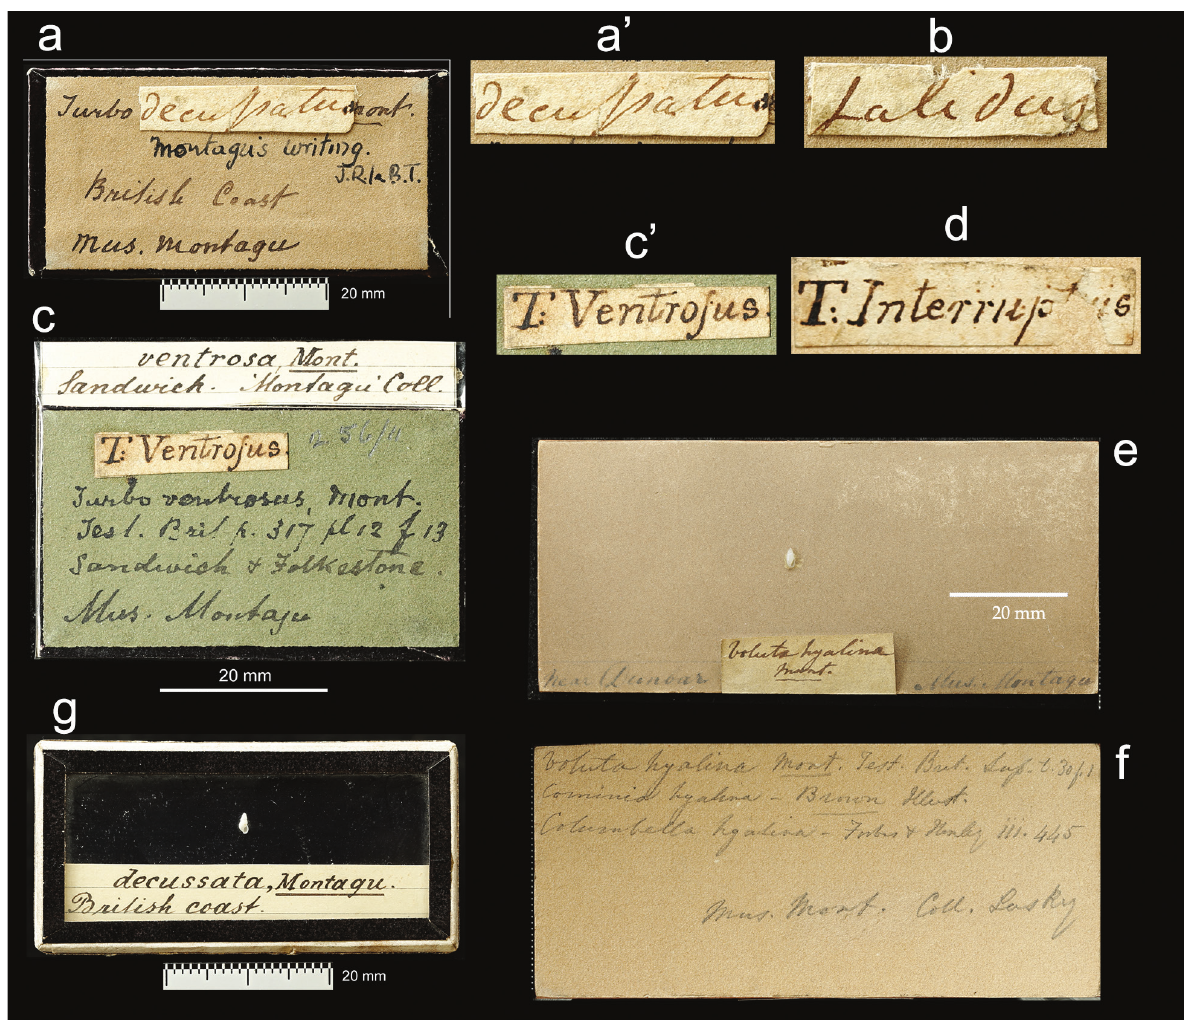
Figure I1. Labels and mounts associated with the Montagu collection in the Natural History Museum, London. a, b Original Montagu identification labels attached to bases of boxes. c, d Old labels associated with the Montagu collection of unknown provenance e, f Old mounting blocks associated with the curatorial work of JE Gray g Late 19th century mount on black paper in glass topped box.